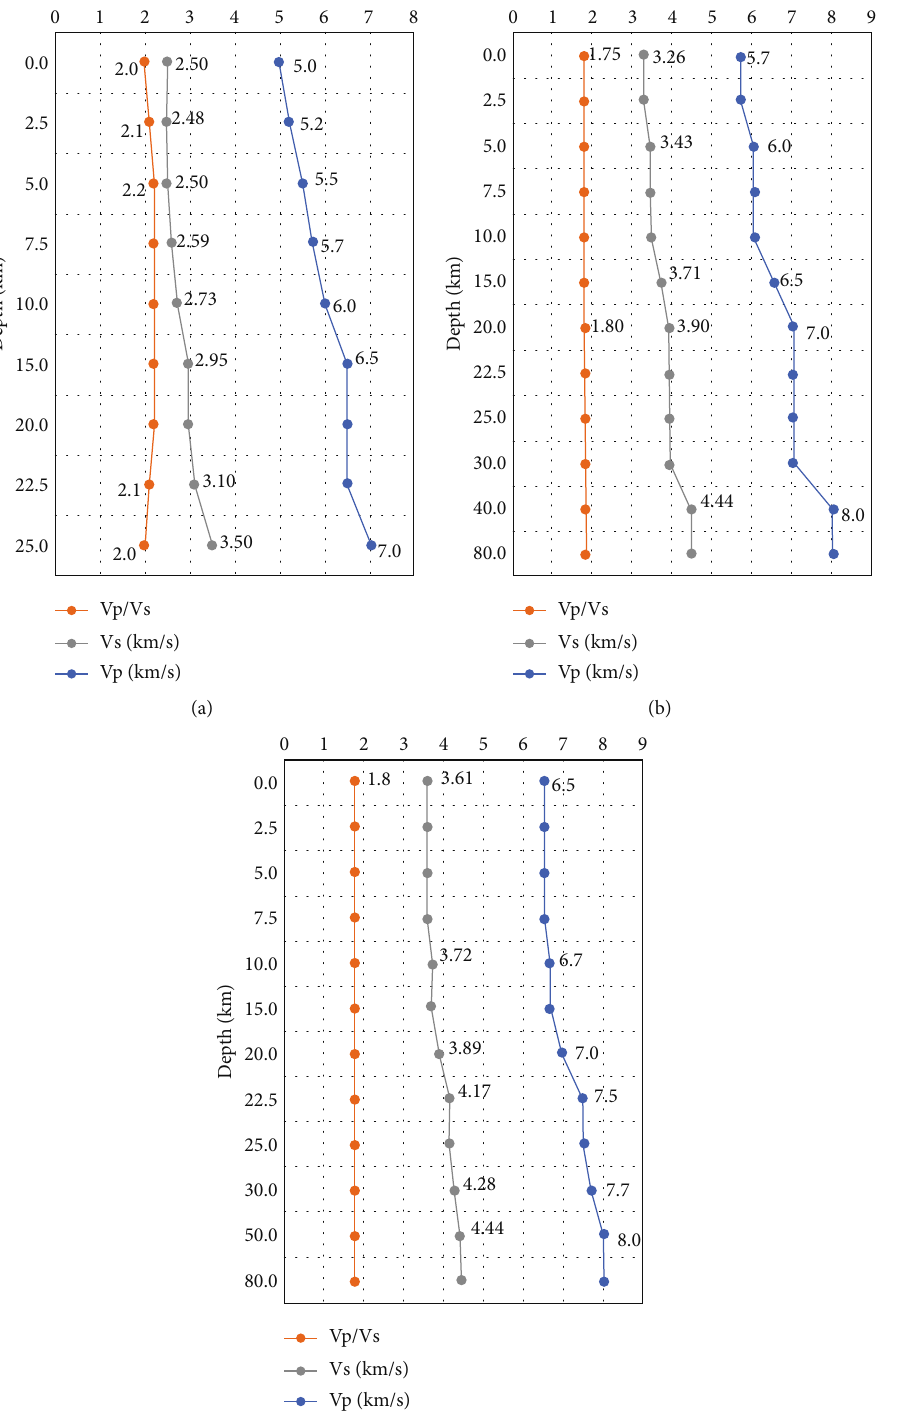
Figure 3: The physical properties (Vp, Vs, and Vp/Vs ratio) used in this modeling. (a) The Vp (blue line), Vs (gray line), and Vp/Vs (orange line) values for the accretionary wedge. (b) The Vp (blue line), Vs (gray line), and Vp/Vs (orange line) values for the continental plate and mantle. (c) The Vp (blue line), Vs (gray line), and Vp/Vs (orange line) values for the oceanic plate and